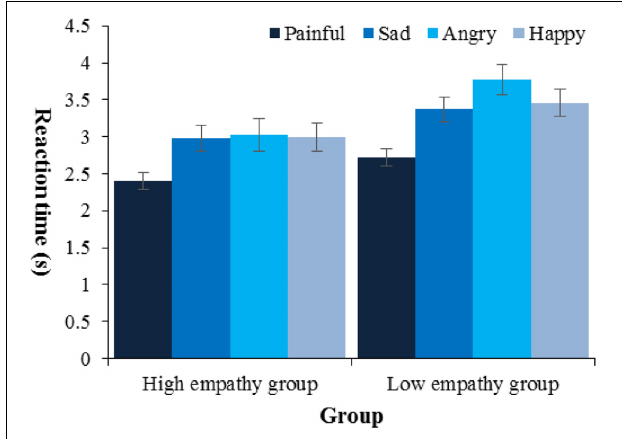
FIGURE 4 | Reaction time by type of target and empathy. Error bars show standard errors in this and the following